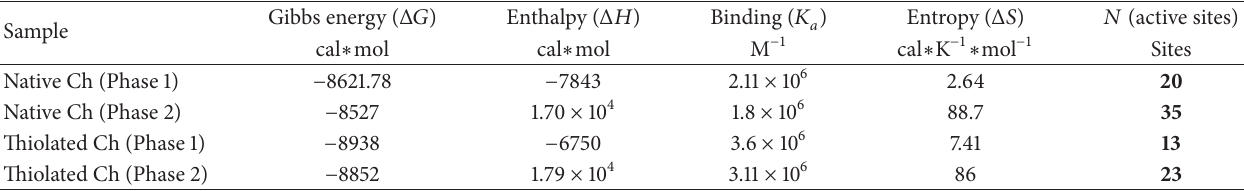
Figure 6: Profile curve of thiolated chitosan nanoparticles NPT 1 (1:114), NPT 2 (1:106), NPT 3 (1:100), NPT 4 (1:94), NPT 5 (1: 86), NPT 6 (1:77), and NPT 7 (1:71). Table 3: Thermodynamic profile of thiolated and native